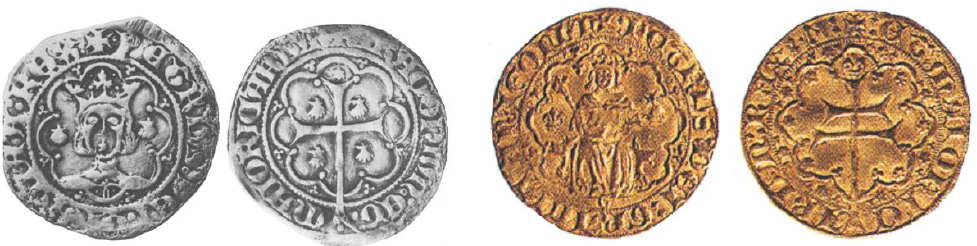
Figure 2. Ral and Ral d’or of Peter IV. Mallorca. Published by Crusafont, Numimsmàtica de la Corona Catalano-Aragonesa medieval (785-1516) ; Vico: Madrid, Spain, 1982; num. 252 and Guia art gòtic, Museu Nacional d’Art de Catalunya: Barcelona, Spain, 1998, p. 54, fig. 1.1.